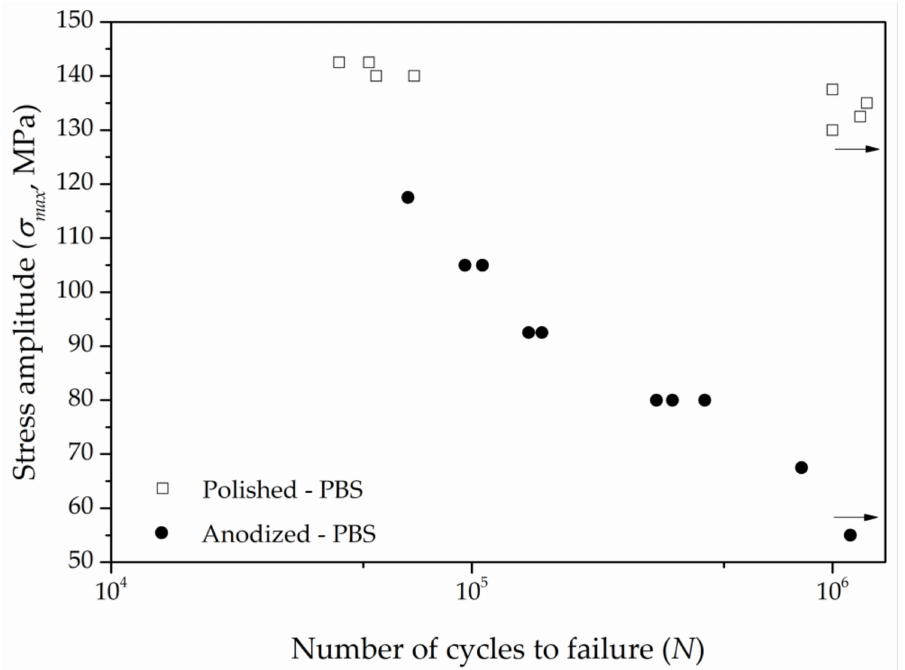
Figure 8. S- N curves for the polished and anodized AZ31B alloy specimens in the PBS solution at room temperature.